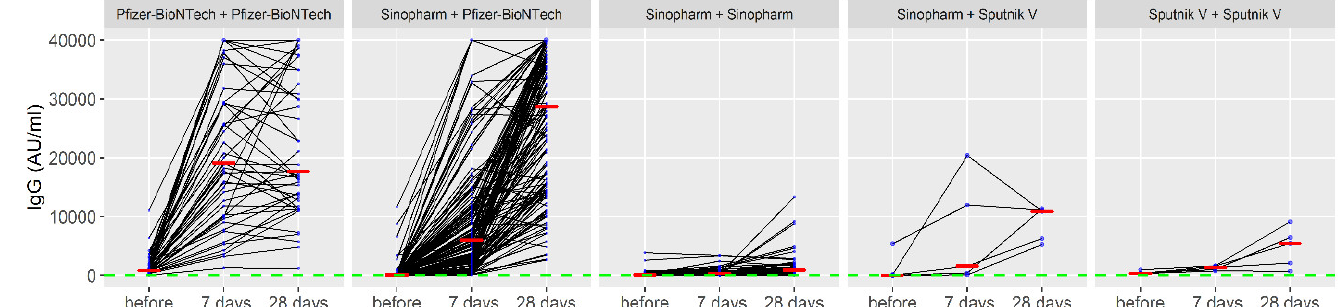
Figure 1. Titers of anti-spike immunoglobulin G during the observed period. The red line repre- sents the median IgG values; the blue circle represents the number of cases with the same IgG val- ues.